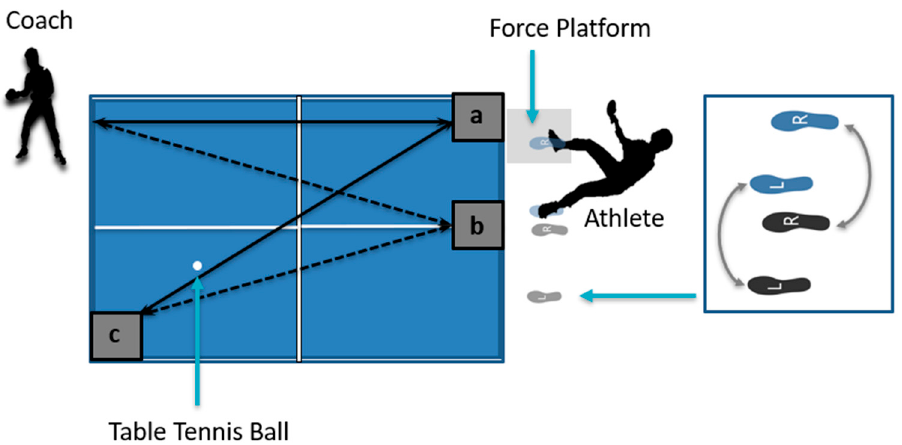
Figure 2. Experimental setup of First Impact Area ( a ), Second Impact Area ( b ), Target Area ( c ), and topspin forehand using